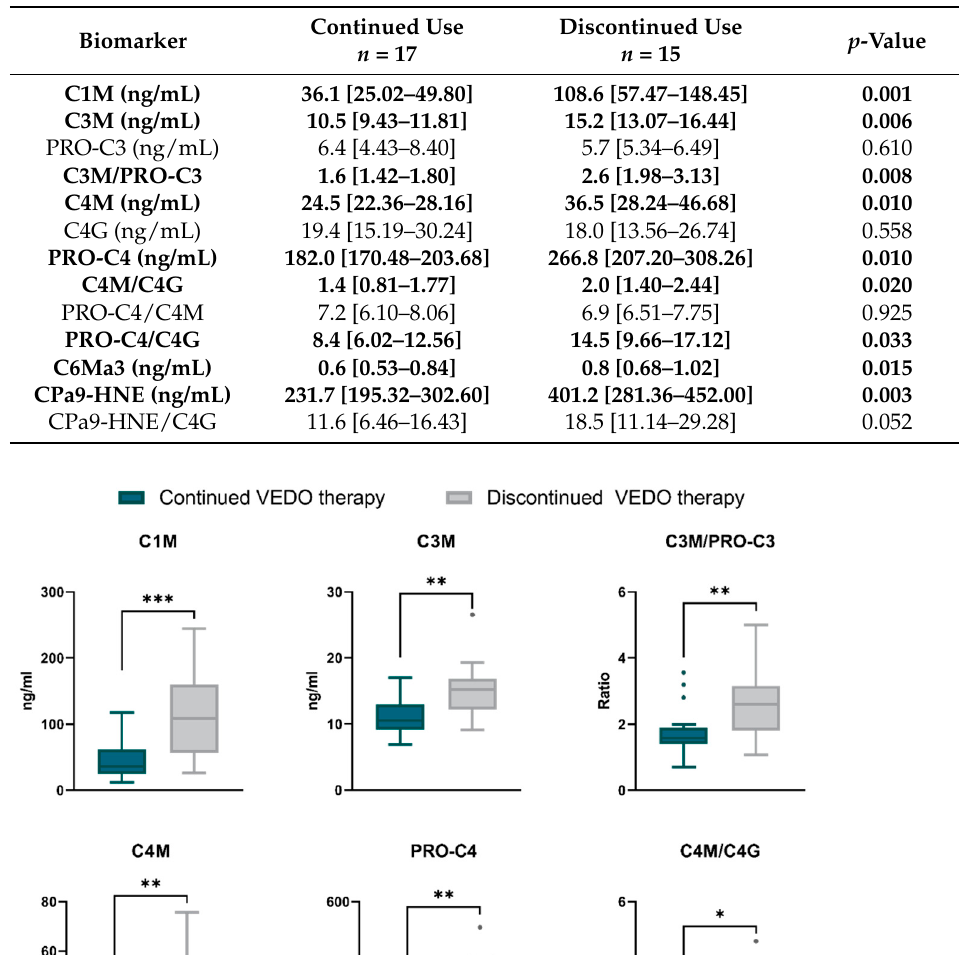
Table 2. Baseline serum biomarker levels stratified by long-term response to vedolizumab. Values are displayed as medians with IQR.